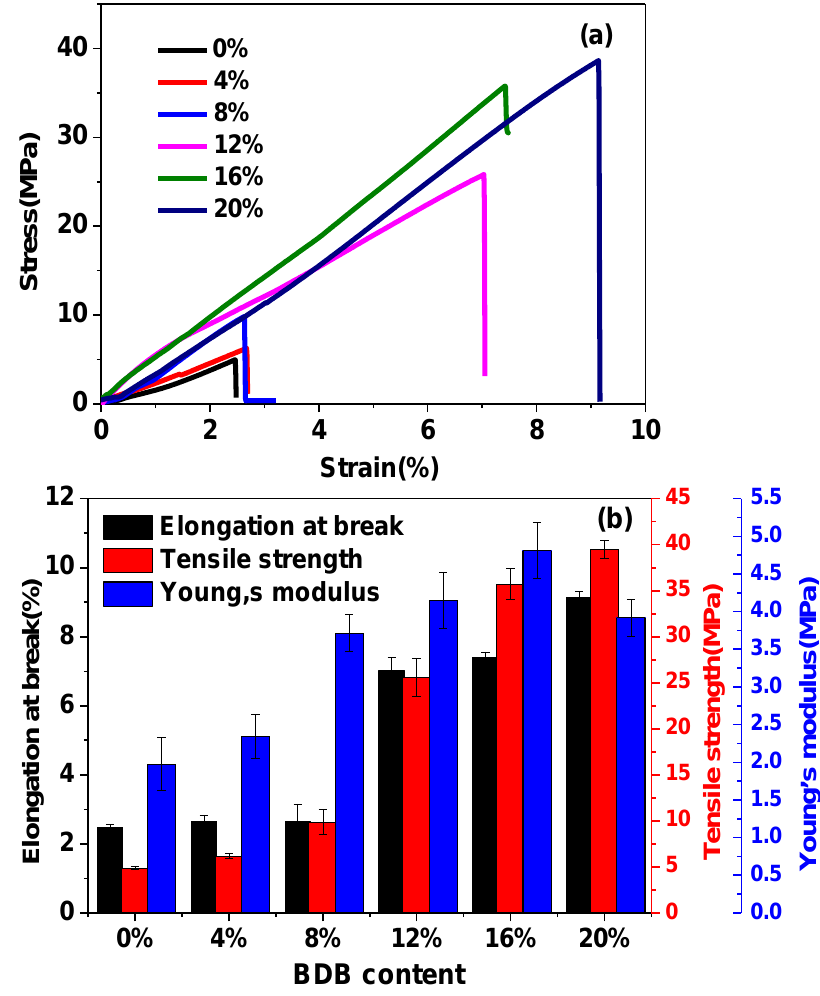
Figure 4. Mechanical properties of FPAE and C-FPAE series with different BDB contents: ( a ) stress– strain curve, ( b ) mechanical properties of the x% C-FPAE series with different cross-linker